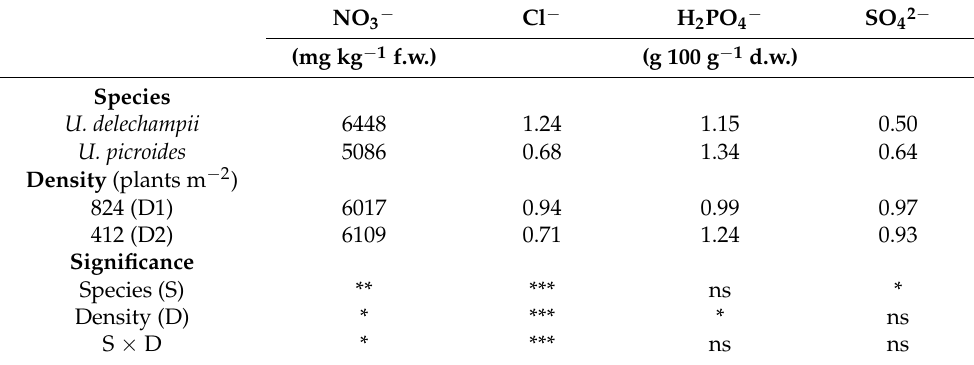
Table 5. Anion content of smooth golden fleece ( U. delechampii ) and prickly golden fleece ( U. picroides ) grown in a floating system at two sowing densities (first harvest). NO 3 − Cl − H 2 PO 4 − SO 42 − (mg kg − 1 f.w.) (g 100 g − 1 d.w.)